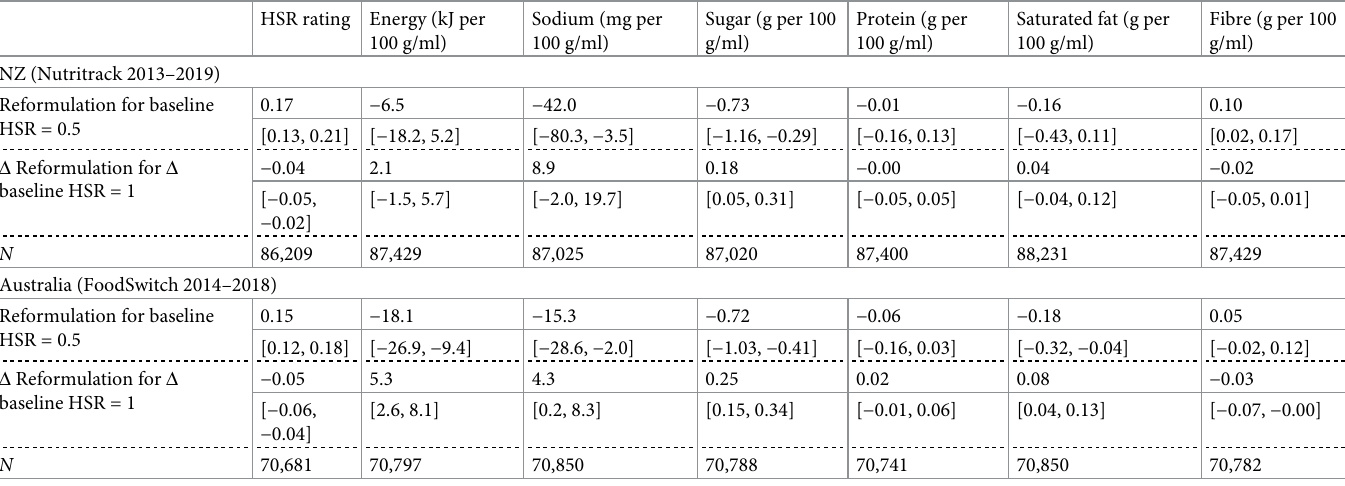
Table 3. Changes in reformulation following voluntary adoption of HSR by baseline HSR